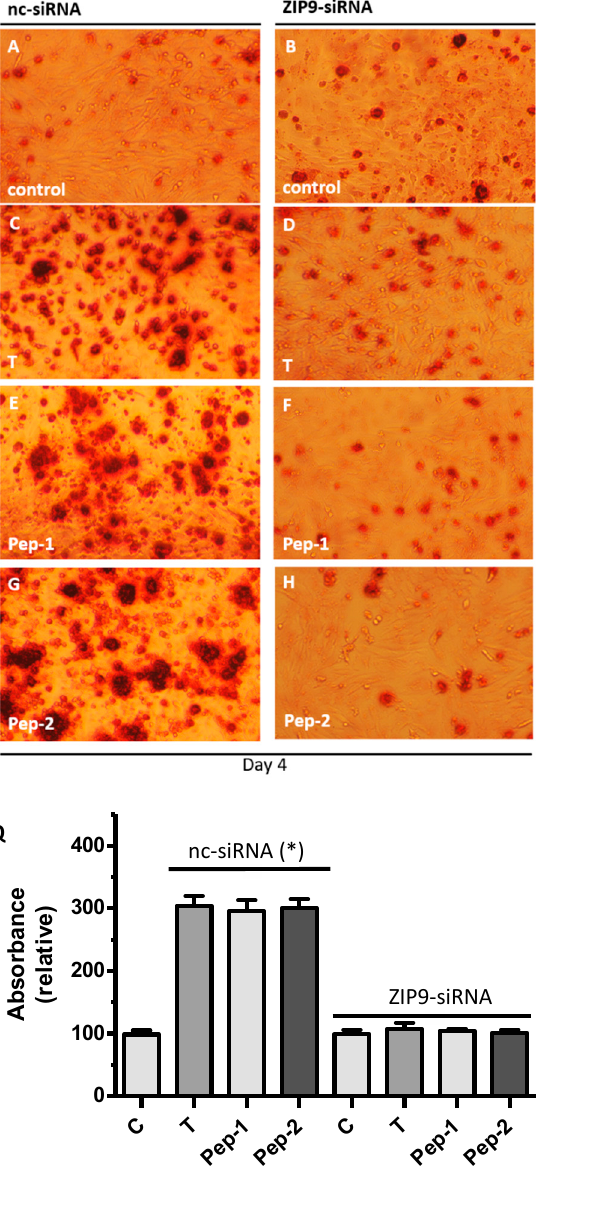
Figure 7. Alizarin Red staining of osteoblastic SAOS-2 cells after silencing ZIP9 expression. Cells were treated with either negative control siRNA (nc-siRNA; all left-hand panels) or ZIP-specific siRNA (ZIP9-siRNA; all right-hand panels) to silence ZIP9 expression. Alizarin Red staining was performed after 4 ( A – H ) or 11 ( I – P ) days of incubation with testosterone, Pep-1, or Pep-2. Controls received vehicle only. After 4 days of incubation: ( A , B ) Alizarin Red staining in control cells; ( C,D ) Alizarin Red staining in the presence of testosterone; ( E , F ) Alizarin Red staining in the presence of Pep-1; ( G , H ) Alizarin Red staining in the presence of Pep-2. After 11 days of incubation: ( I , J ) Alizarin Red staining in control cells; ( K , L ) Alizarin Red staining in cells treated with testosterone; ( M , N ) Alizarin Red staining in cells treated with Pep-1; ( O , P ) Alizarin Red staining in cells treated with Pep-2. ( Q ) Quantification of Alizarin Red after 4 days of incubation ( n = 3; means ± SEM; * p ≤ 0.05). ( R ) Quantification of Alizarin Red after 11 days of incubation ( n = 3; means ± SEM; * p ≤ 0.05).